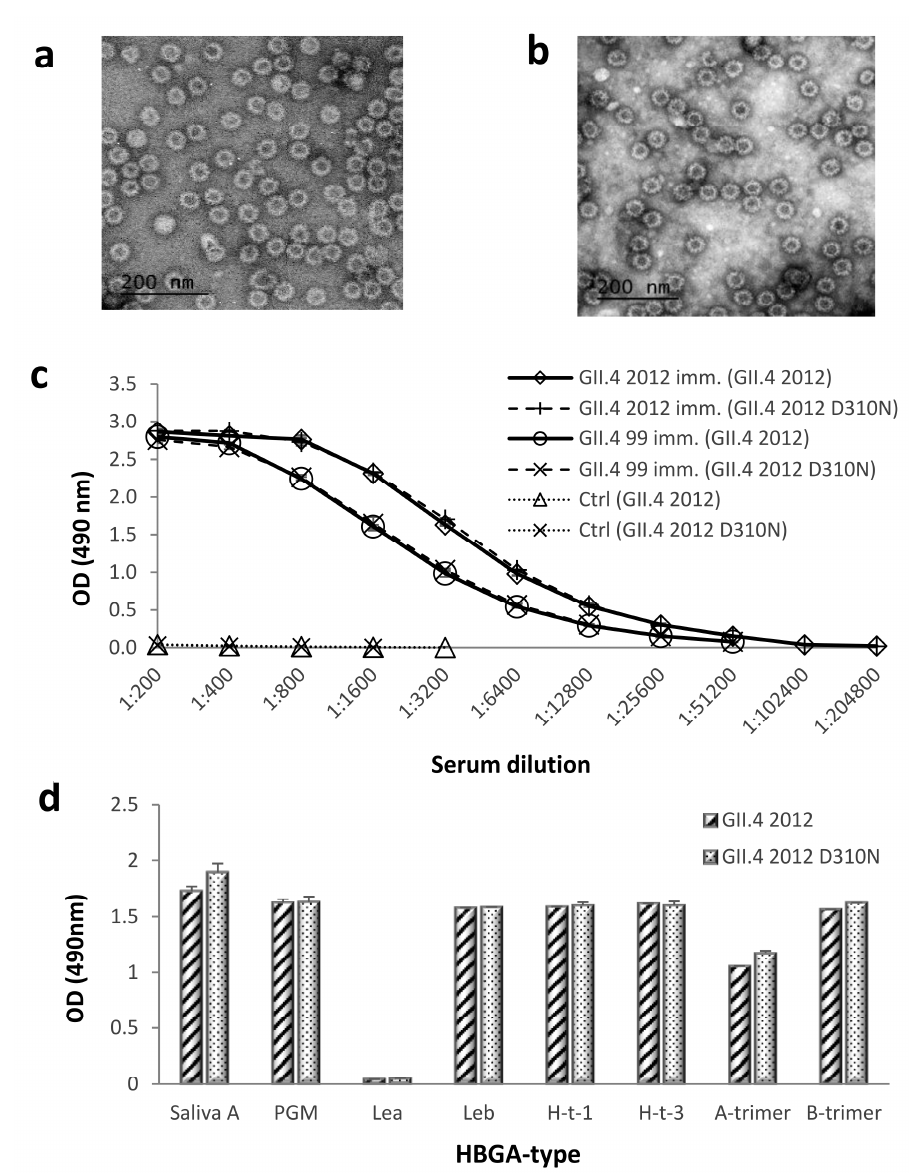
Figure 3. Morphology, antigenicity, and histo-blood group antigen (HBGA) binding of wild-type and mutated GII.4 2012 virus-like particles (VLPs). Morphology of GII.4 2012 D310N ( a ) and GII.4 2012 ( b ) VLPs were examined by FEI Tecnai F12 electron microscope (Philips 487 Electron Optics, Holland) after negative staining with 3% uranyl acetate pH 4.6. Mutated GII.4 2012 D310N VLPs and wild-type GII.4 2012 VLPs were used as antigens with enzyme-linked immunosorbent assay (ELISA), reacting with GII.4 2012, GII.4 1999, and control mice (ctrl) immune sera ( c ). VLPs were assayed for binding to saliva type A, pig gastric mucin (PGM), and synthetic histo-blood group antigens as described in the Materials and Methods ( d ). The symbols ( c ) and bars ( d ) illustrate the mean optical density (OD) at 490 nm of replicate wells (2–4) with standard errors. Le a , Lewis a ; Le b , Lewis b ; H-t-1, H-type-1; H-t-3, H-type